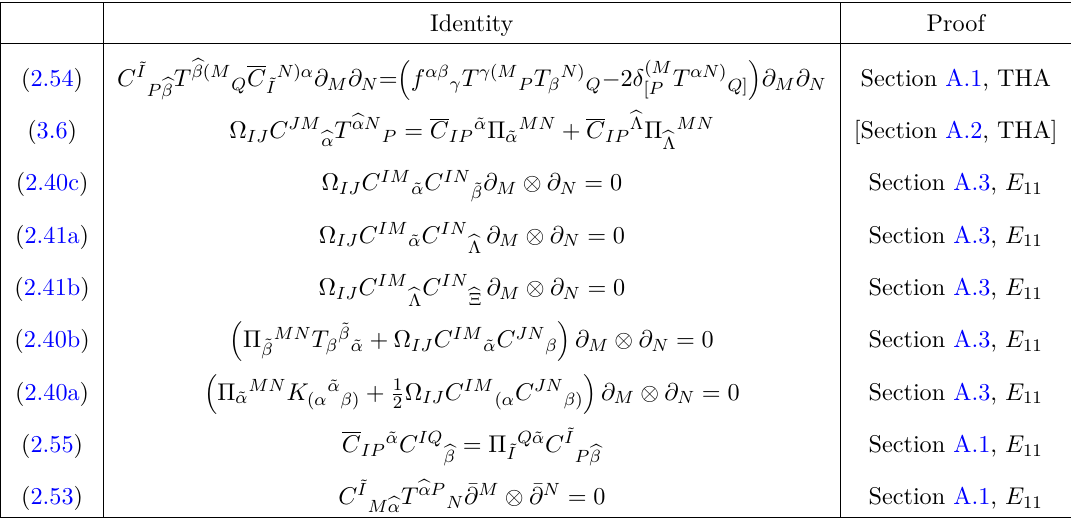
Table 5 . Summary of identities satisfied by the various E 11 objects. Identities that are only valid on a solution to the section constraint (2.19) are shown contracted with partial derivatives. The identity (3.6) plays a crucial rôle in gauge invariance of the duality equation, and we sometimes refer to it as the master identity. It is the only identity in the table for which we do not have a complete